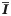
Whole-cell balanced amplification had a considerable impact on the probability that very short voltage transients would elicit a spike.A. An alpha function-like time course of increased rate activation of excitatory synapses was induced (tau = 12 ms, multiplication factor = 5) resulting in brief (half time ~ 30 ms) excursions of voltage bumps. B. For each trace (30 bumps of voltage elevations) the probability of eliciting a spike was calculated before and after whole cell balanced amplification. The simulation parameter space was spanned by varying the resting membrane potential, the synaptic strength, and the activation frequency of the synapses as indicated in the Materials and Methods. Binning the probabilities in all conditions resulted in highly non-linear amplification, where bumps that had a low likelihood of eliciting a spike were amplified to threshold values with probabilities of 50%. Using Eq 2 we tested whether the multiplication of σ and I¯ by a factor of 1.7 could account for the simulation results. β was set such that the maximum frequency was 100 Hz or 150 Hz [58] at values where the average current was 3σ more depolarized than threshold (a range in which sodium channels still do not undergo pronounced inactivation). The parameter space (35 different sets of simulations) was spanned by varying I¯σ (0.4–0.9, similar to the values obtained in the simulations) and the threshold θσ (0.5–3.7), yielding results that spanned the same area as the simulations. The values of I¯σ are indicated by color coding, and the values of β are indicated by solid lines (max firing frequency of 150 Hz) and double lines (max firing frequency of 100 Hz). C. Binning these calculated values based on the probability before whole-cell amplification yielded a curve that was similar to the simulated curve.